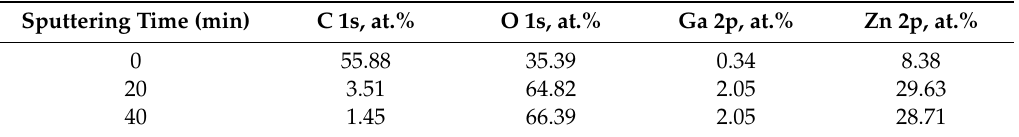
Table 3. Atomic percentage concentration of the elements in ZGO film, deposited at the sputtering voltage 0.5 kV after 0, 20, and 40 min of etching.